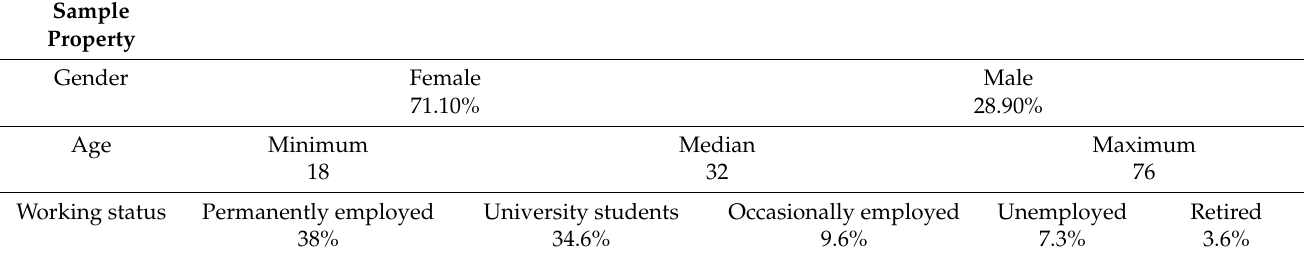
Table 1. Sample properties from Study